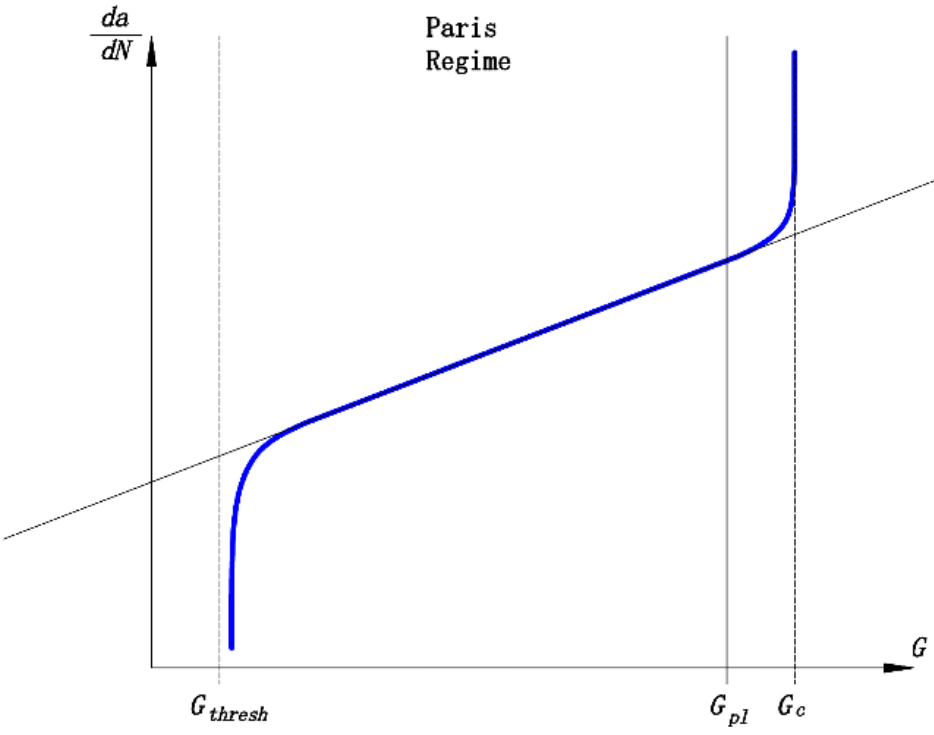
Figure 11. Fatigue crack growth governed by the Paris law.